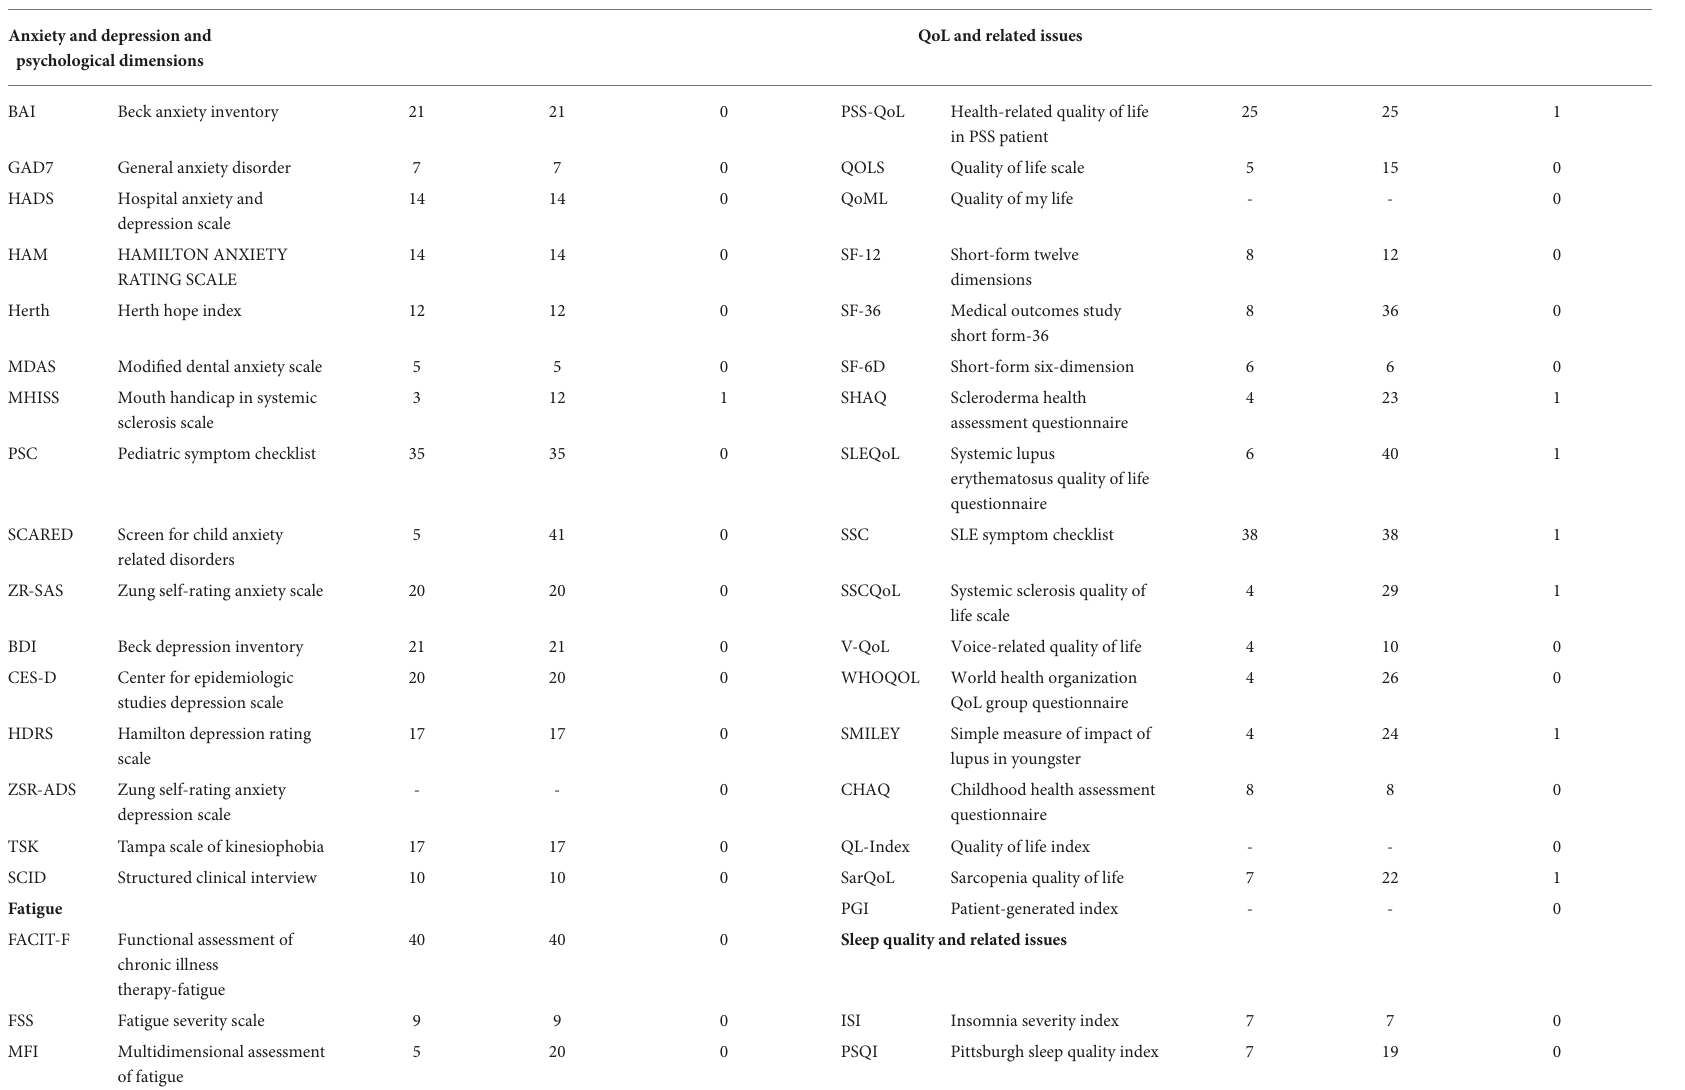
TABLE 2 Classification of questionnaires adopted per scope, no. of domains, no. of issues, and disease specificity. Acronym